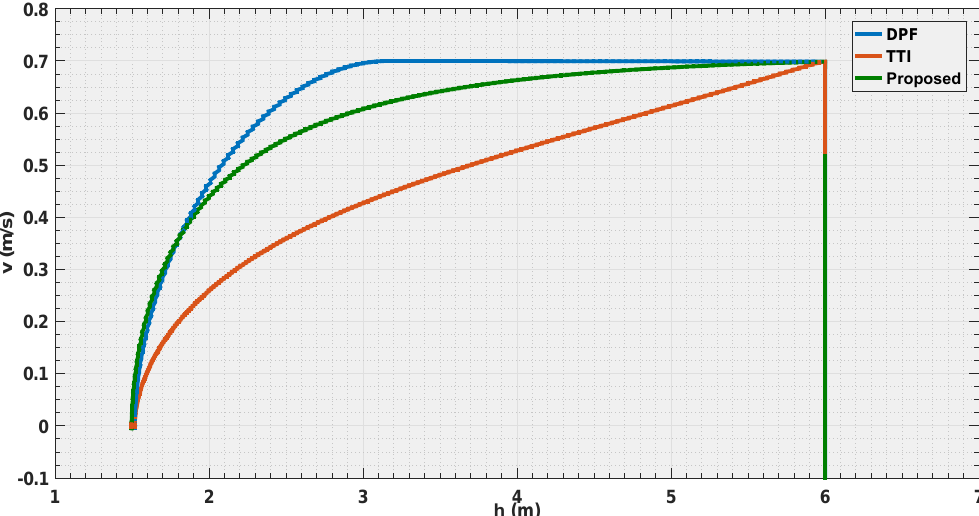
Figure 14. Reference velocity with respect to the distance for the three evaluated algorithms Experiment 1